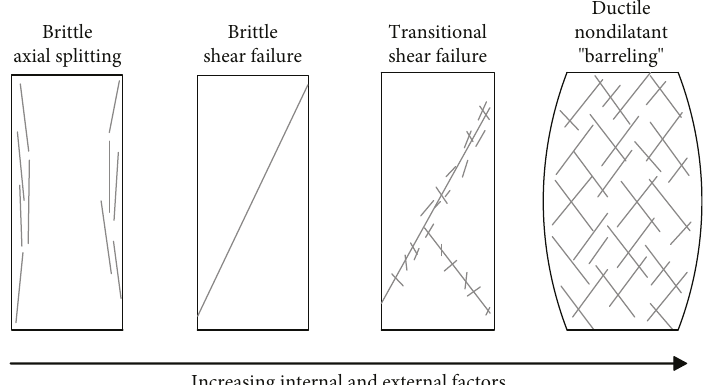
Figure 8: Schematic illustrating changes in failure patterns in relation to internal and external factors and ductility (revised from [44]).